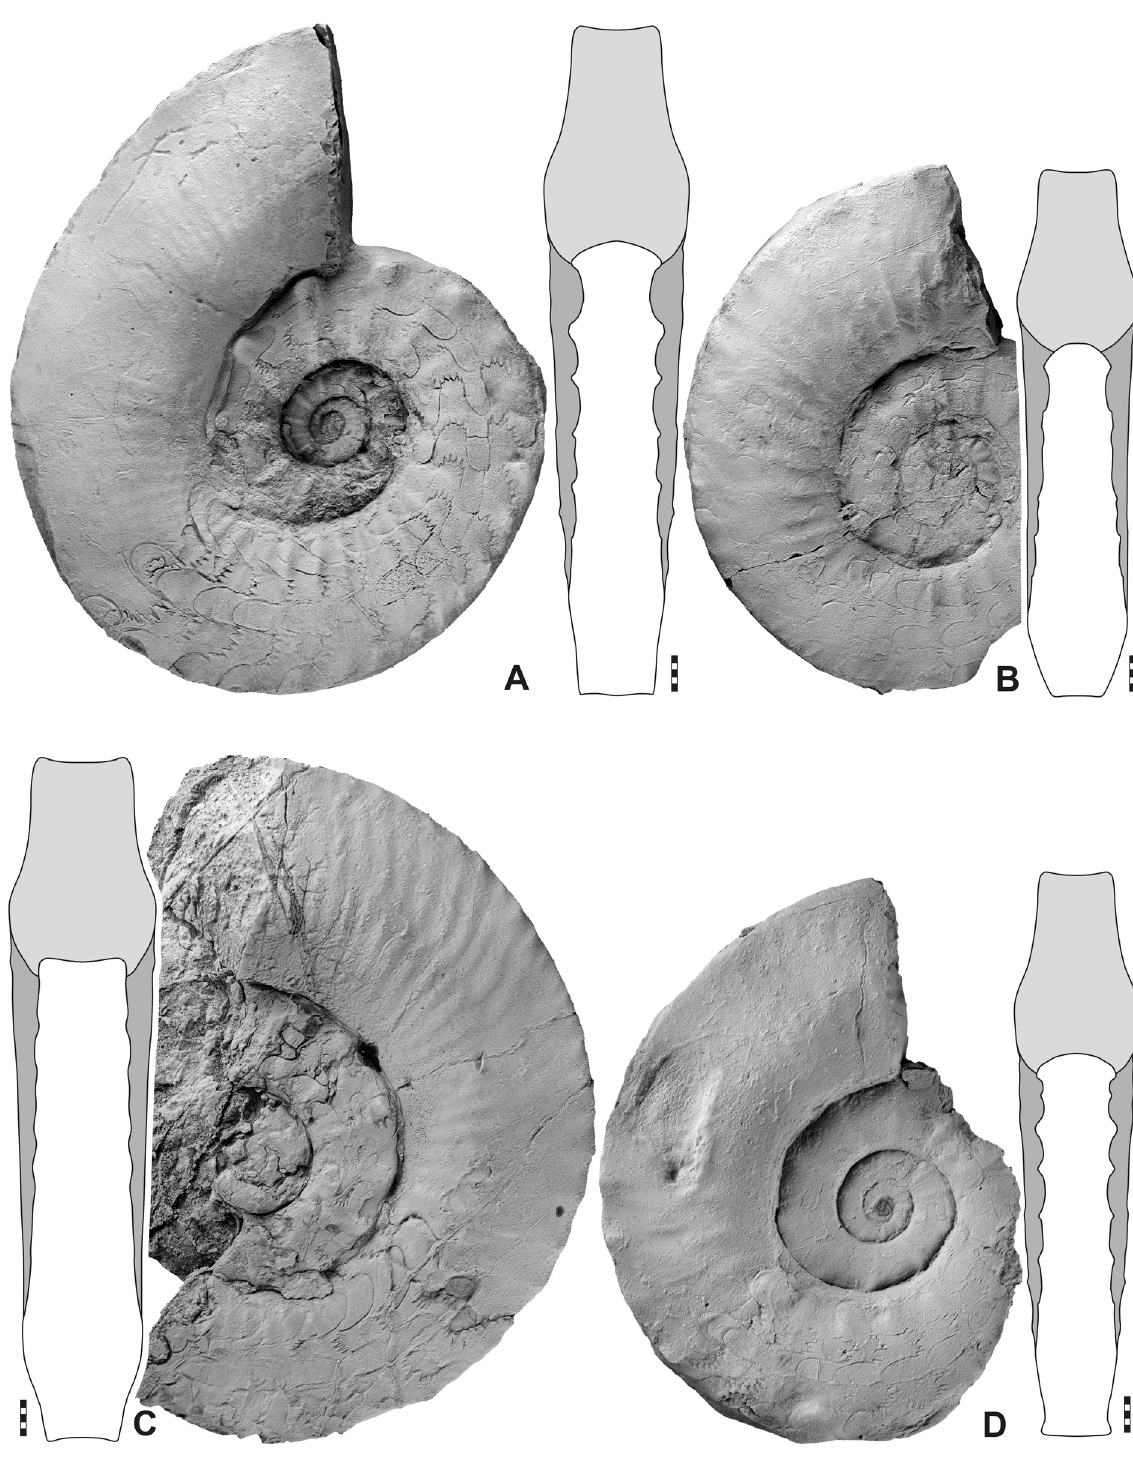
Fig. 51. Lutites lyriformis Korn & Hairapetian sp. nov., lateral and dorsal views. A . Holotype MB.C.29995, section A, float. B . Paratype MB.C.29997, section C, -1.00 m. C . Paratype MB.C.29996, section C, -1.45 m. D . Paratype MB.C.29999, section G, -1.20 m. Scale bar units =